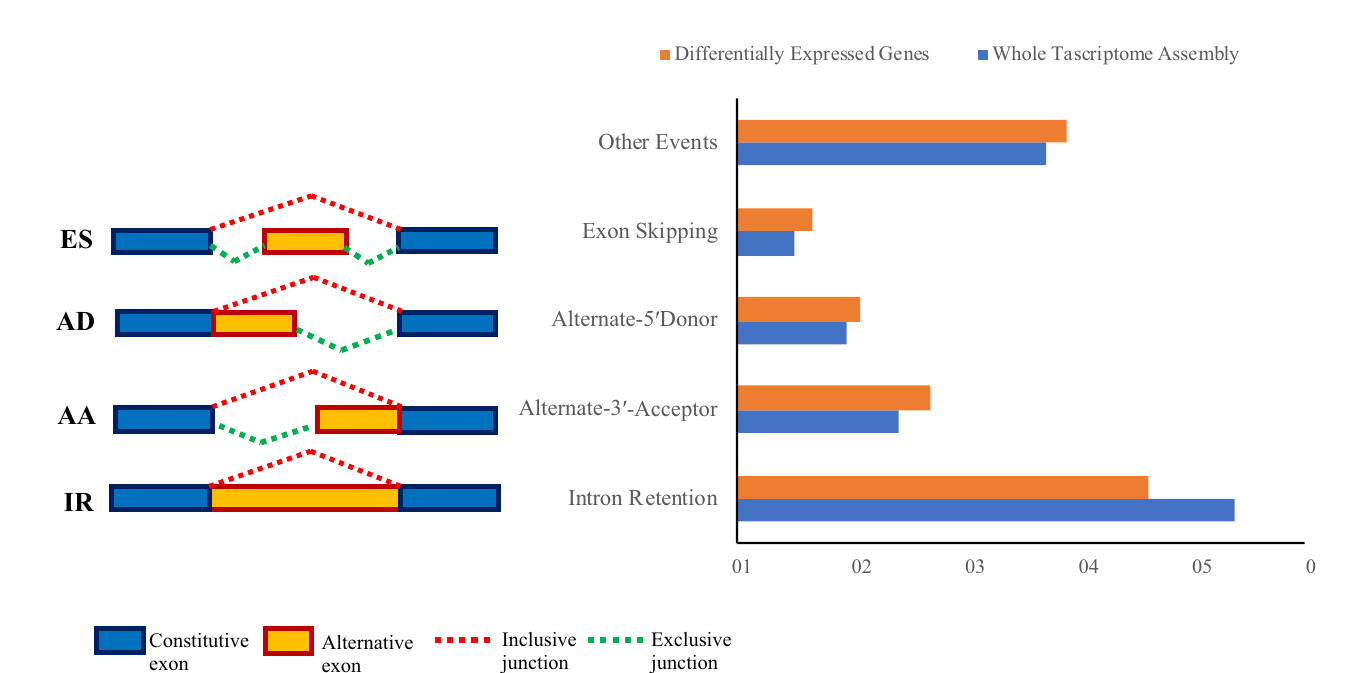
Fig 4. Analysis of alternative splicing. Bar chart showing the percentage of different types of alternative splicing events at the whole trascriptome assembly and differentially expressed genes AD: Alternate-5 0 Donor; AA: Alternate-3 0 -Acceptor, IR: Intron Retention and ES: Exon Skipping.